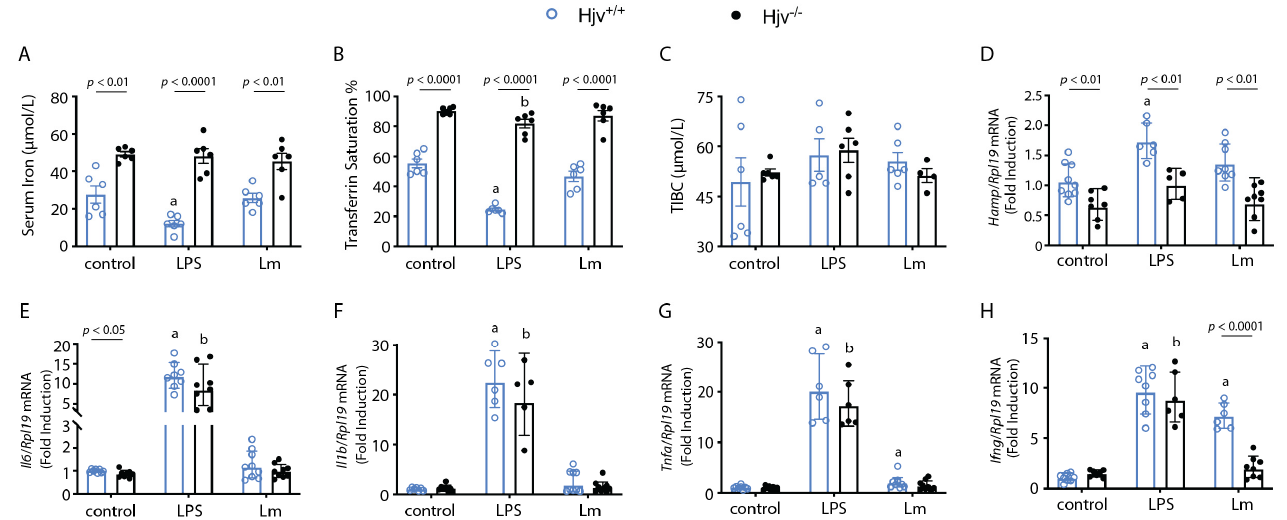
Figure 3. Leishmania ’s major acute infection does not trigger a hypoferremic response. Hjv +/+ and Hjv − / − mice were injected intraperitoneally with either phosphate-buffered saline (control), the endotoxin LPS, or 10 8 L. major stationary phase parasites (Lm). Then, 6 h post-infection, blood was collected via cardiac puncture. Serum was separated from whole blood and used for analysis of ( A ) serum iron, ( B ) transferrin saturation, and ( C ) total iron binding capacity (TIBC). Liver samples were collected; RNA was extracted and used for analysis of ( D ) Hamp, ( E ) Il6 , ( F ) Il1b , ( G ) Tnfa , and ( H ) Ifng mRNAs by qPCR. Data in ( A – C ) are presented as mean ± SEM, while data in ( D – H ) are pre- sented as geometric mean ± geometrical SD. Statistical differences compared with untreated Hjv +/+ or Hjv − / − mice are indicated by a or b, respectively.